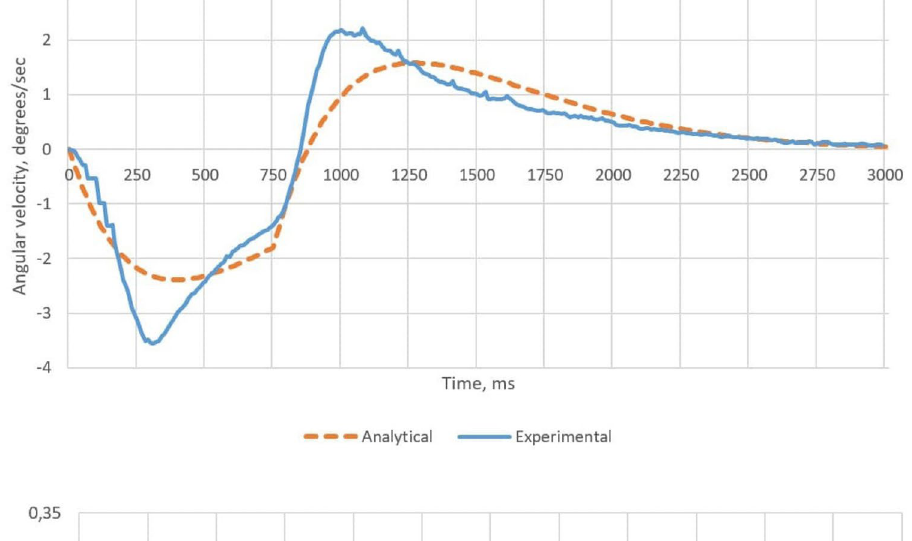
Fig. 6 Velocity of the